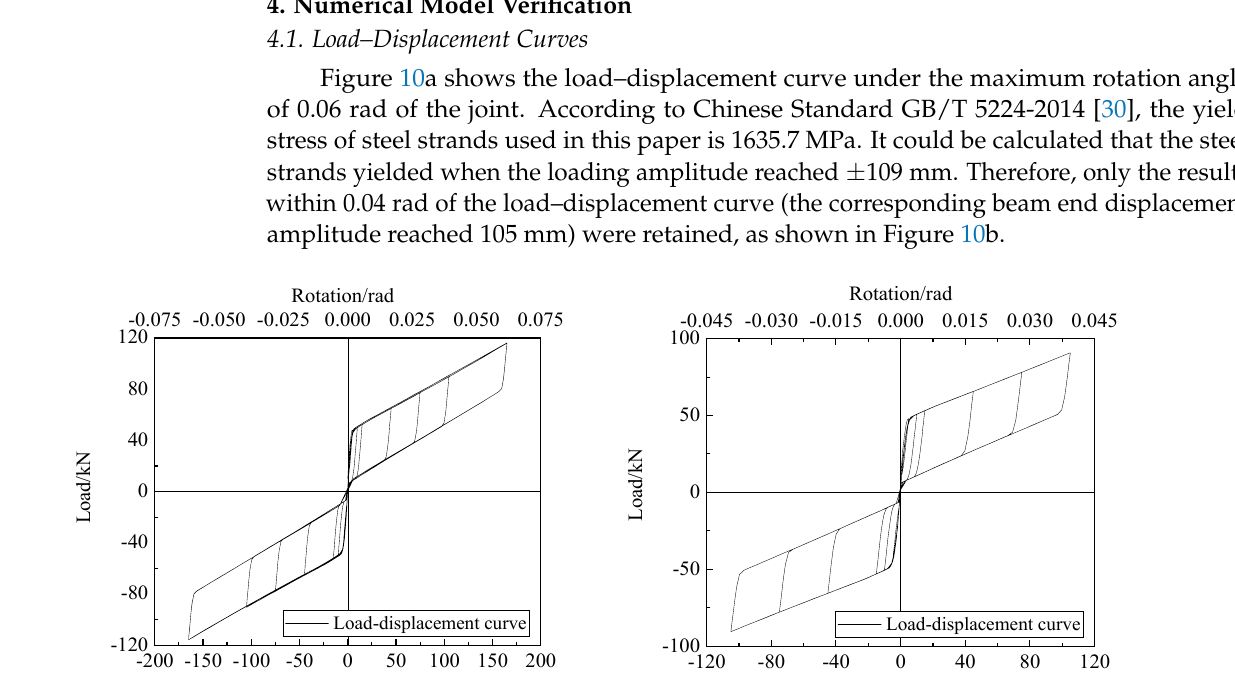
Figure 9. Loading protocol: ( a ) Boundary conditions; ( b ) Loading history.